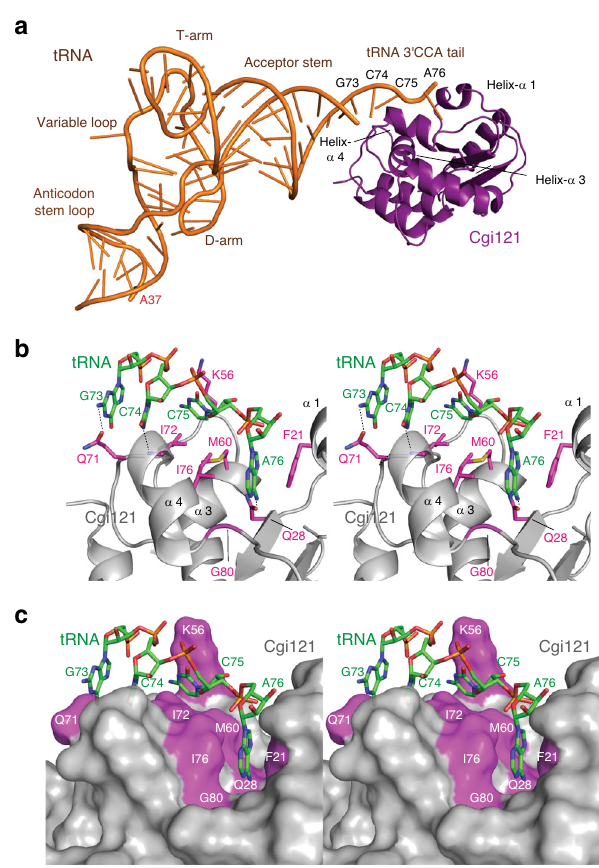
Fig. 2 Crystal structure of the mj Cgi121 – mj tRNA Lys UUU complex. a Ribbon representation of the mj Cgi121 (purple) bound to mj tRNA Lys UUU (orange). b , c Zoom-in stereo views of the binding interface between mj Cgi121 and mj tRNA Lys UUU . For ease of viewing, only the tRNA tail region encompassing 5 ′ - 73 GCCA 76 -3 ′ tail (green) and side chains of Cgi121 mediating direct contacts are shown in stick